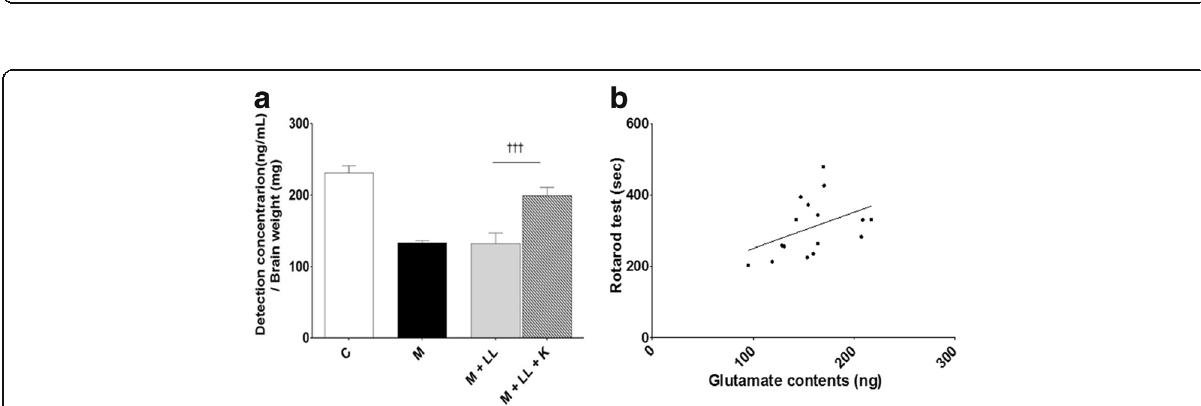
Fig. 7 Effects of combination treatment on glutamate content in the motor cortex. Bar graph showing the glutamate content in motor cortex ( a ). Regression test between glutamate content and the rotarod test ( b ). A higher glutamate content had significant correlation with increased performance on the rotarod test. *** p < 0.001 vs. control group, ### p < 0.001 and # p < 0.05 vs. MPTP group, and ††† p < 0.001 and † p < 0.05 vs. each dose of -dopa only. C: control, M: MPTP, K: KD5040, LL: low dose of L